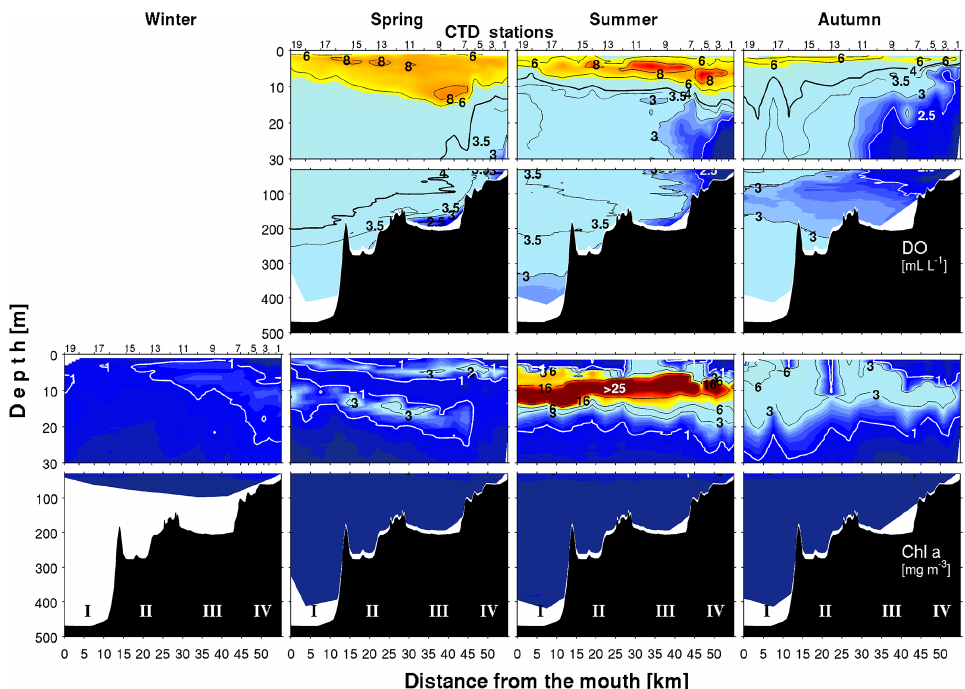
Figure 5. Along-fjord seasonal distribution of dissolved oxygen (above) and chlorophyll (below) for winter, spring, summer and autumn. The figure includes the CTD station number in the top of each panel and the sub-basins numbers below. No DO measurements were obtained during